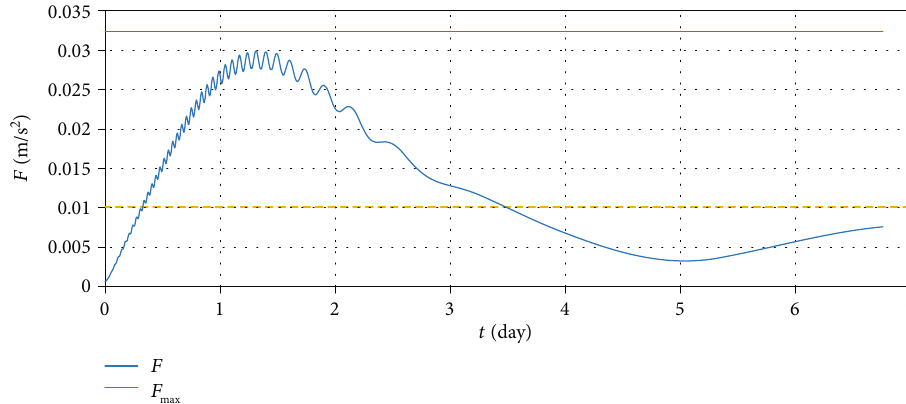
Figure 19: Pro fi le of the thrust